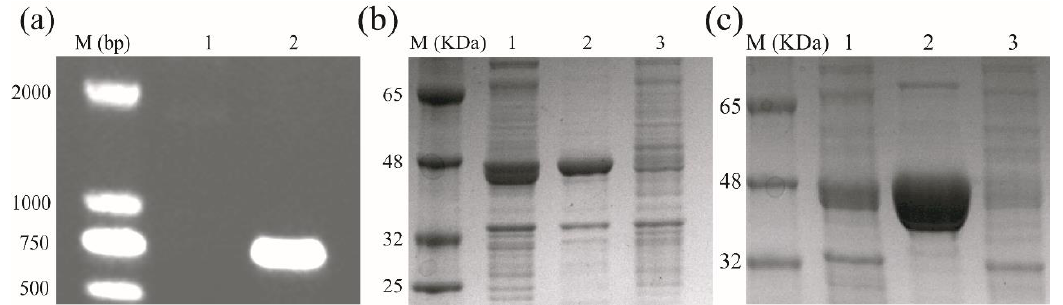
Figure 1. Preparation of purified EreB: ( a ) agarose gel electrophoresis: Lane 1: empty plasmid of E. coli ; Lane 2: recombinant E. coli ; ( b ) SDS-PAGE electrophoresis: Lane 1: supernatant of the EreB-expressing cells; Lane 2: sediment of the EreB-expressing cells; Lane 3: empty plasmid of E. coli ; ( c ) Lane 1: supernatant of the EreB-expressing cells; Lane 2: purified enzyme; Lane 3: empty plasmid of E. coli .